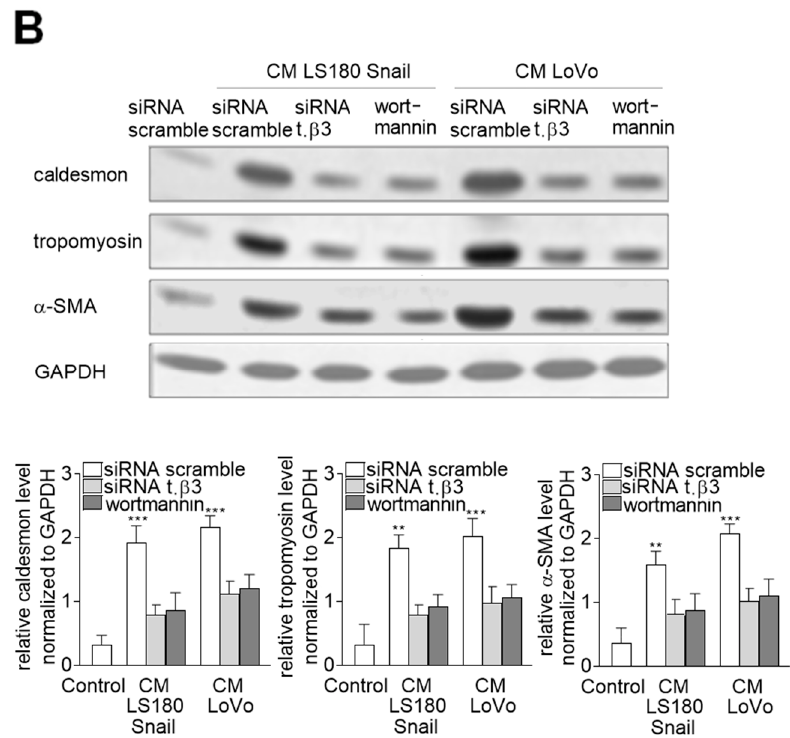
Figure 4. Phosphorylation of tubulin- β 3 in CAF-like cells is the response for contraction protein expressions. ( A ) HMEC-1 cells were cultured in medium supplemented with conditioned medium (CM) isolated from invasive (LS180 Snail, LoVo) colon cancer cells where TGF- β 2 was depleted (d. TGF- β 2) for 216 h or where ( B ) tubulin- β 3 were silenced (siRNA t. β 3), or phosphorylation of tubulin- β 3 were inhibited by wortmannin. Then, the levels of contraction proteins (caldesmon, tropomyosin, and α -SMA) were determined by Western blot assay. The protein levels are normalized to GAPDH. The results are provided as means ± SD ( n = 3); ** p < 0.01, *** p < 0.005. The blots are representative of three independent experiments.